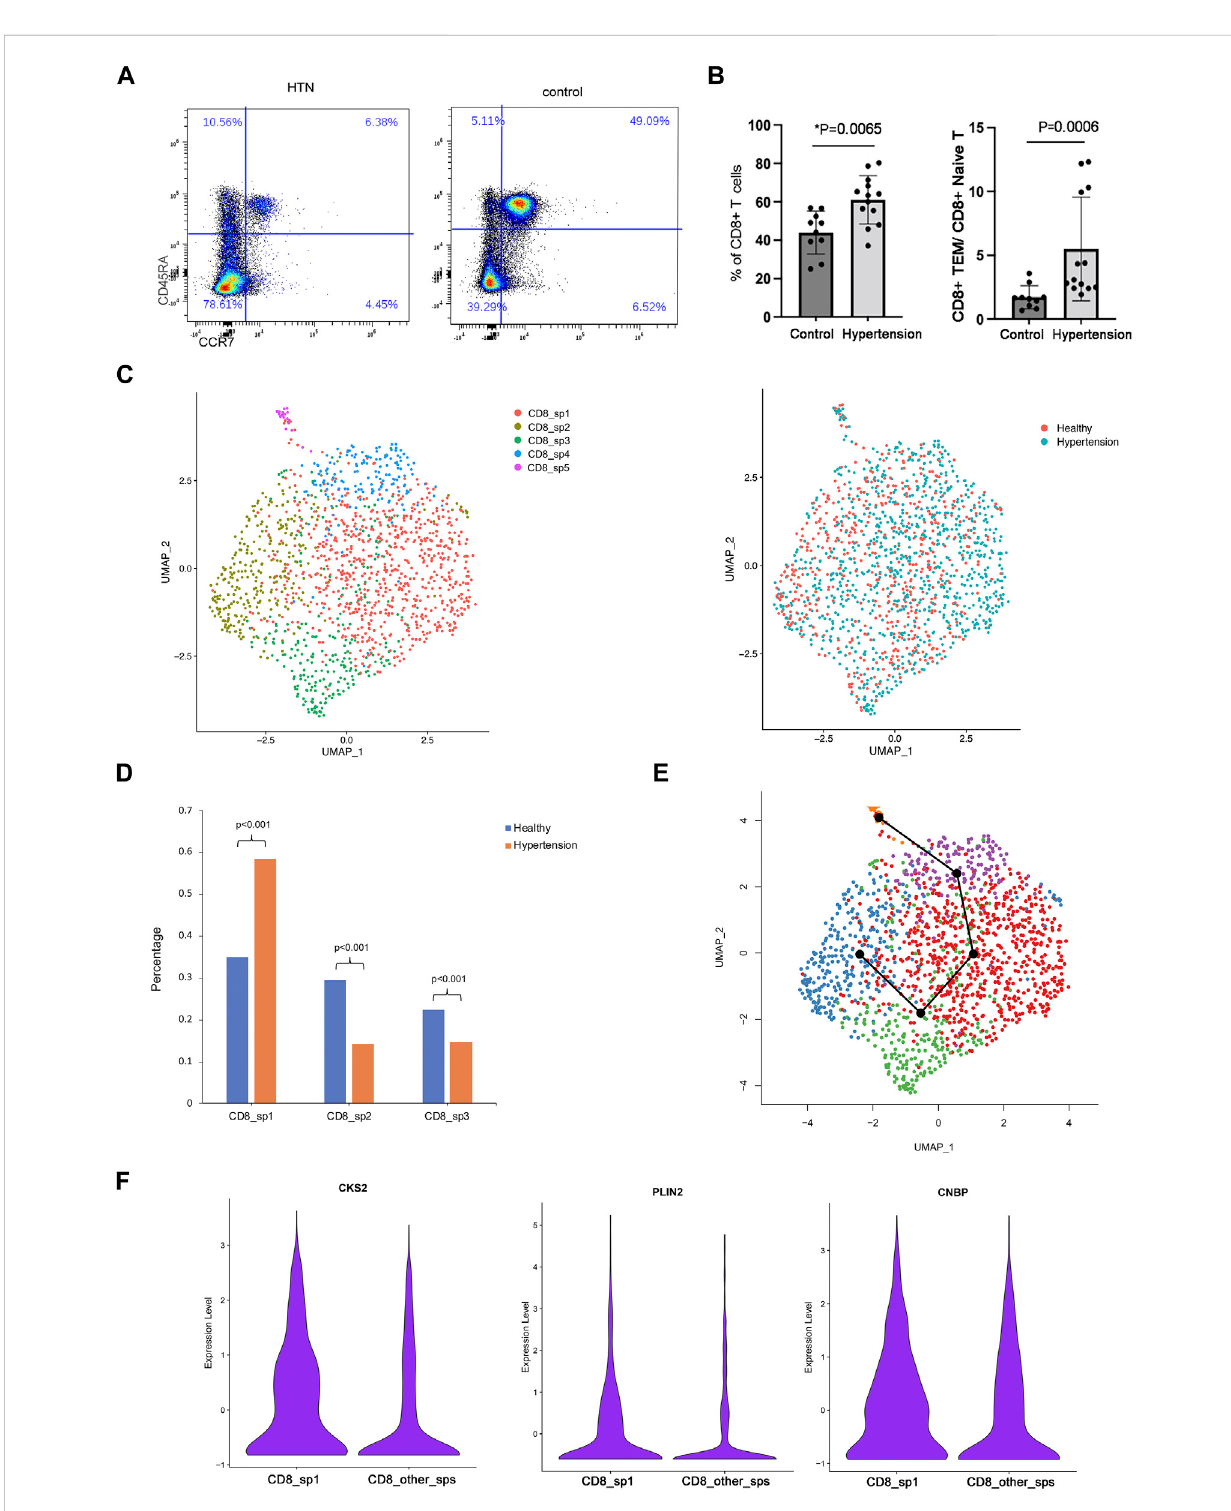
FIGURE 3 Subcluster analysis of CD8 TEM cells. (A) Flow cytometry analysis of CD8 effector memory T cells and the ratio of CD8 TEM to naïve T cells in the peripheral blood of healthy donors ( n = 10) and hypertensive patients ( n = 13). (B) UMAP visualization of fi ve CD8 TEM subpopulations. (C) UMAP visualization of the distribution of CD8 TCM cells from healthy donors or hypertensive patients. (E) Trajectory reconstructed using Slingshot for CD8 TM cells. (F) Violin plot showing marker genes of subpopulation 1.